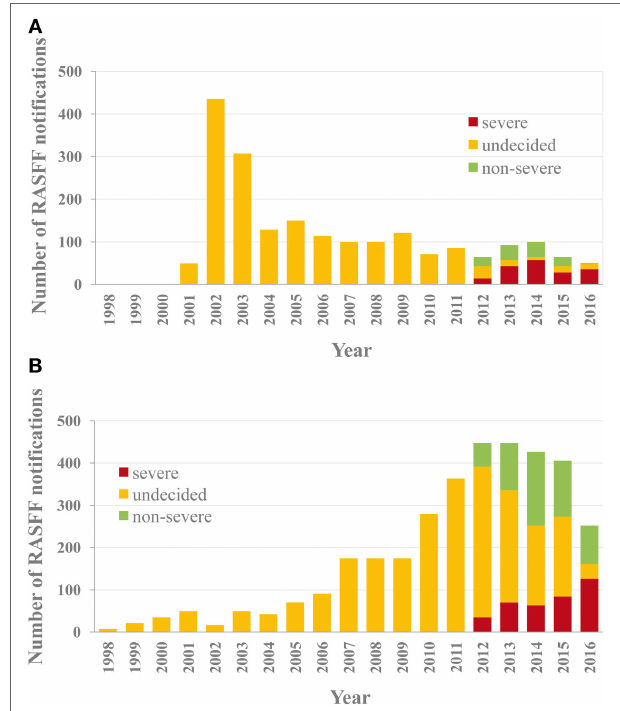
FiGURe 1 | Notifications regarding residues of veterinary drugs (A) and pesticide residues (B) in agricultural products between 1998 and 2016 in the Rapid Alert System for Food and Feed (RASFF) database. The proportion of assessment-based risk severity decision categories is indicated after